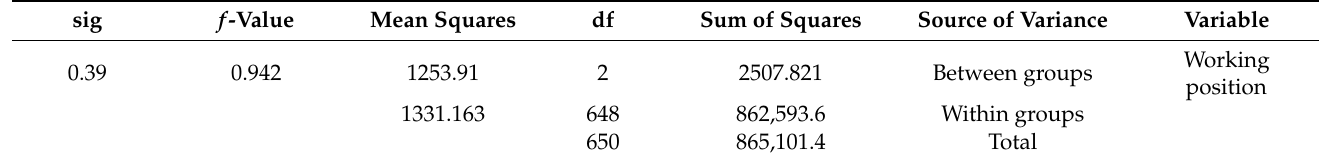
Table 5. ANOVA for differences in anxiety about COVID-19 infection by workplace. sig Mean Squares df Sum of